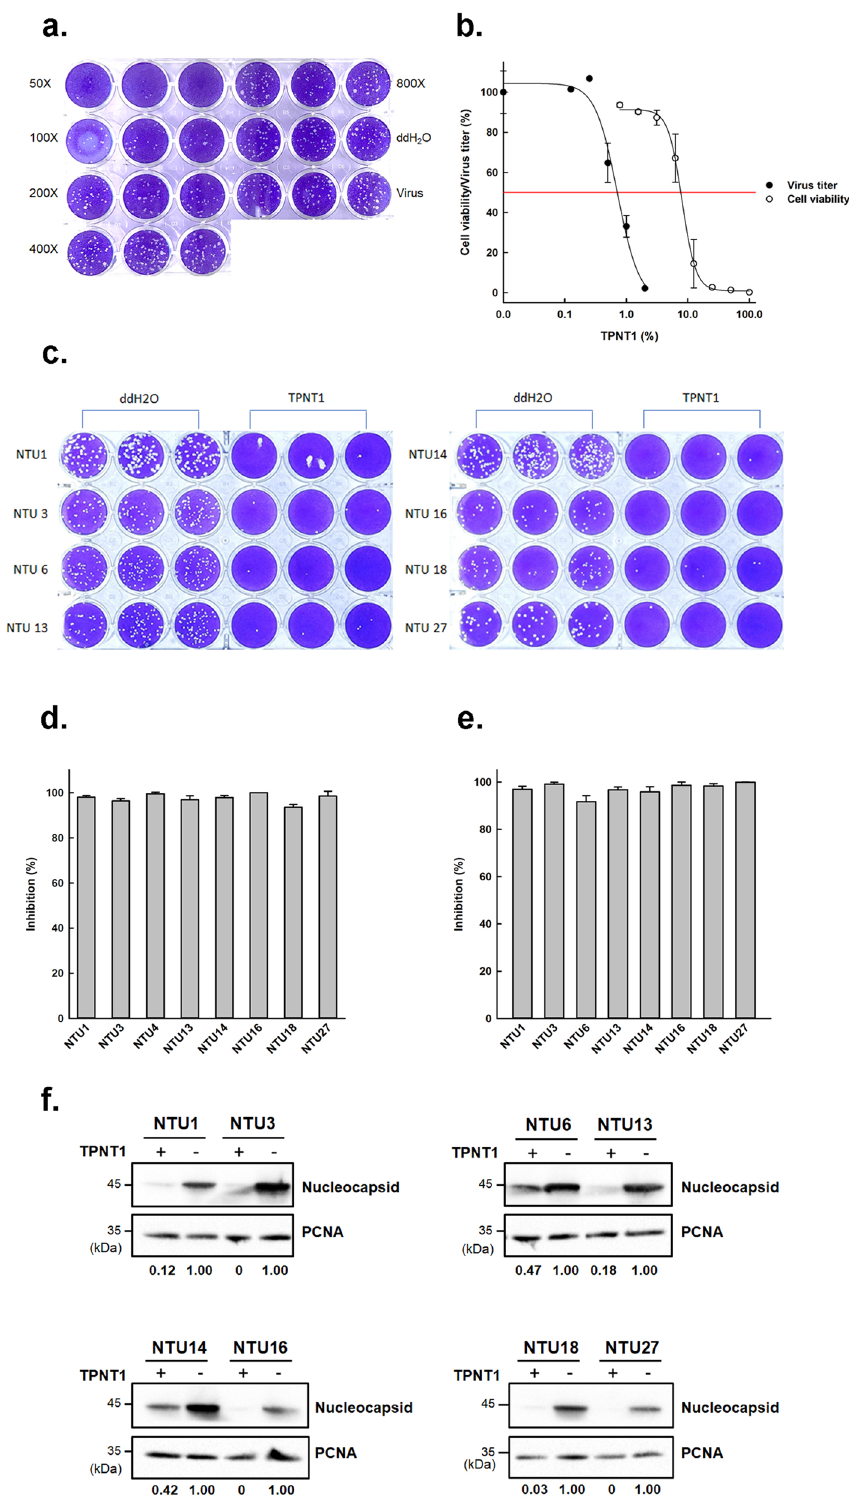
Figure 2. The antiviral activities of TPNT1 against SARS-CoV-2 in vitro. ( a ) Inhibition of plaque formation in the presence of serially diluted TPNT1. ( b )The half maximal effective concentration (EC 50 ) and cell toxicity of TPNT1 for Vero E6 cells was determined by plaque reduction assay and ACP assay, respectively. ( c ) Plaque reduction assay of TPNT1(1:50 dilution) against various SARS-CoV-2 strains. ( d ) The percentage of inhibition by plaque reduction assay in ( c ). ( e ) Inhibition of virus titers in the supernatants of SARS-CoV-2 infected H1975-ACE2 cells by TPNT1. ( f ) Inhibition of viral nucleocapsid (NP) protein expression in TPNT-1 treated SARS-CoV-2 infected H1975-ACE2 cells. The ratio of NP to the internal loading control, proliferating cell nuclear antigen (PCNA), was shown below each blot. At least three independent experiments were performed and one representative result was shown. Full-length blots/gels of ( f ) were presented in Supplementary Fig.